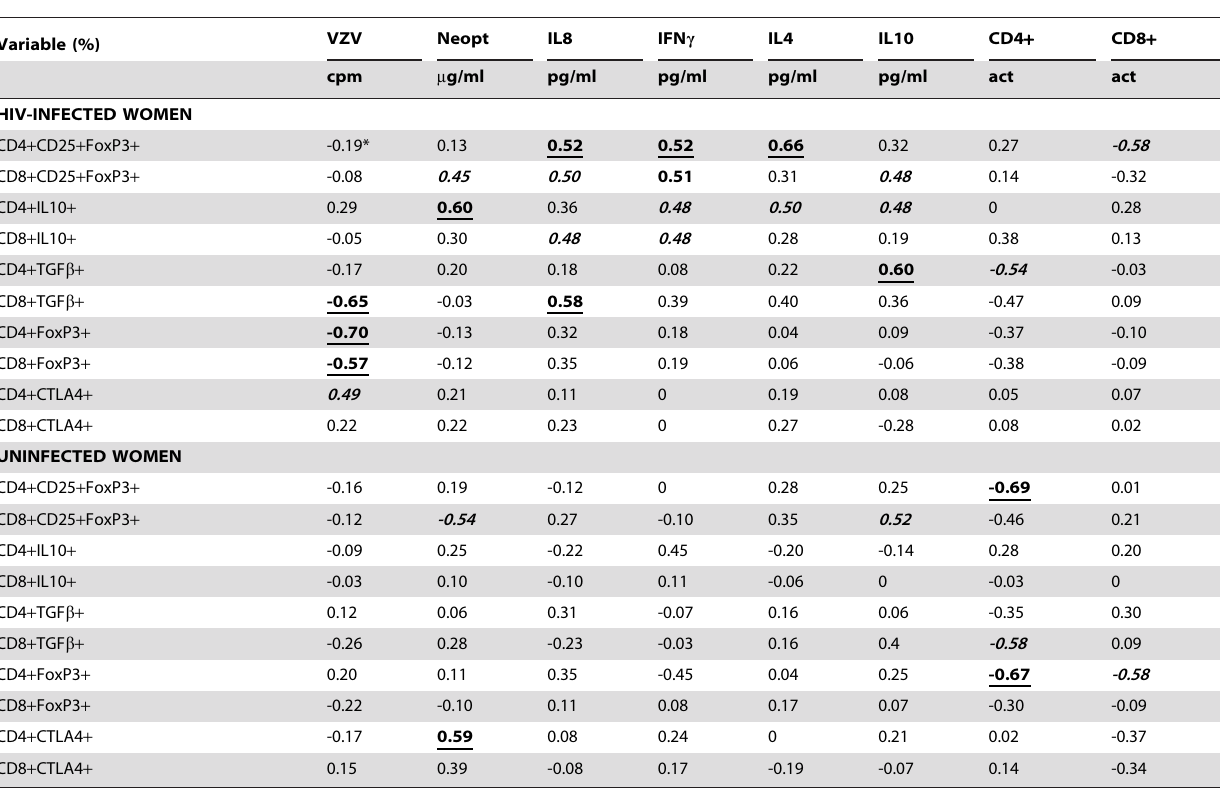
*Numbers represent Spearman correlation coefficients. Bold-facing and underscore indicates significant associations, with p , 0.05; bold-facing and italics indicates marginally significant associations with p values of 0.05 to